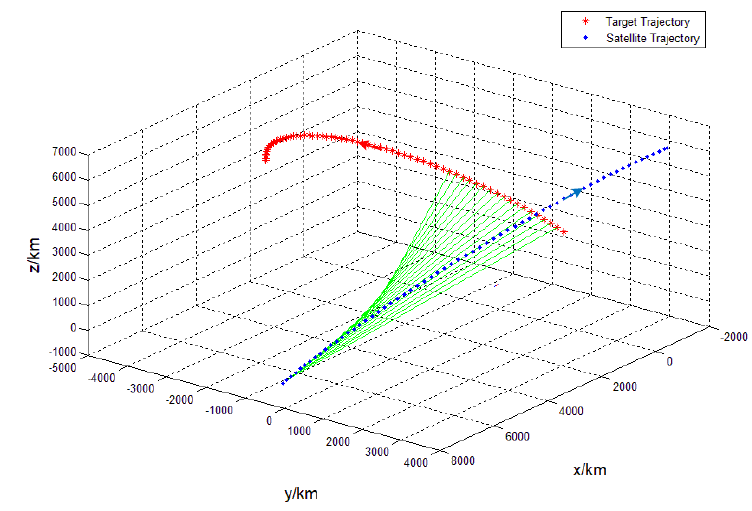
Figure 8. Trajectory of satellite and target with access link.